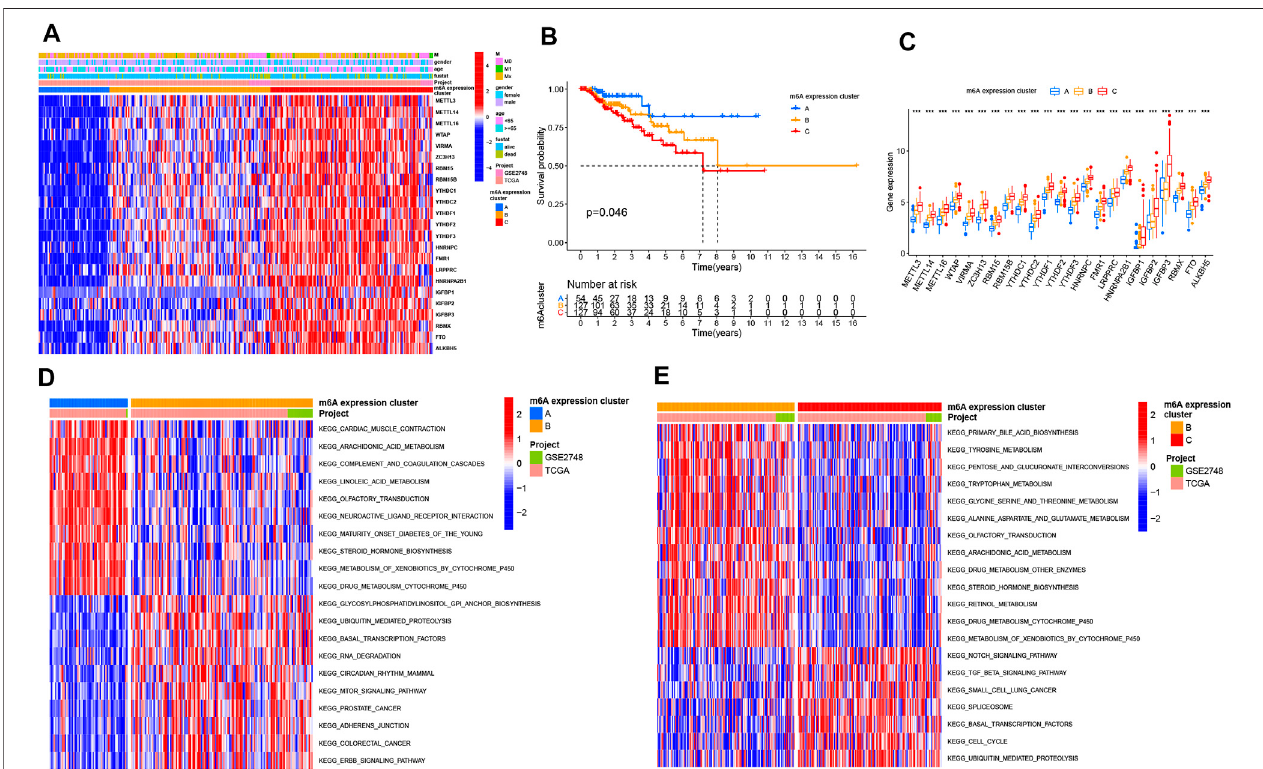
FIGURE2| Distinct m 6 Amodi fi cation patterns and biological features ofeach cluster. (A) Unsupervisedclusteringof23m 6 AgenesinTCGA PRCC and GSE2748 data sets. The m 6 A expression cluster, tumor M stage, survival status, gender, and age were used as annotations. Red means high expression of m 6 A genes, and blue represents low expression. The M means metastasis. (B) Kaplan – Meier survival analysis showing the OS for the three m 6 A expression clusters based on TCGA PRCC andGSE2748datasets.Alog-ranktestwasperformed. (C) Expressionpatternof23m 6 Agenesamongthreem 6 Aexpressionclusters.Theupperandlowerends oftheboxesmeaninterquartilerange(IQR) ofthevalues.Thelinesintheboxesrepresent eachthemedianvalue.Theasterisksrepresent the p value.(* p < .05;** p < .01; *** p < .001) (D , E) GSVA enrichment analysis depicting the activation states of the biological processes in three m 6 A expression clusters. In the heat map, red means activated pathways, and blue means inhibited pathways. (D) m 6 A expression clusters B vs. A (E) m 6 A expression clusters B vs. C.